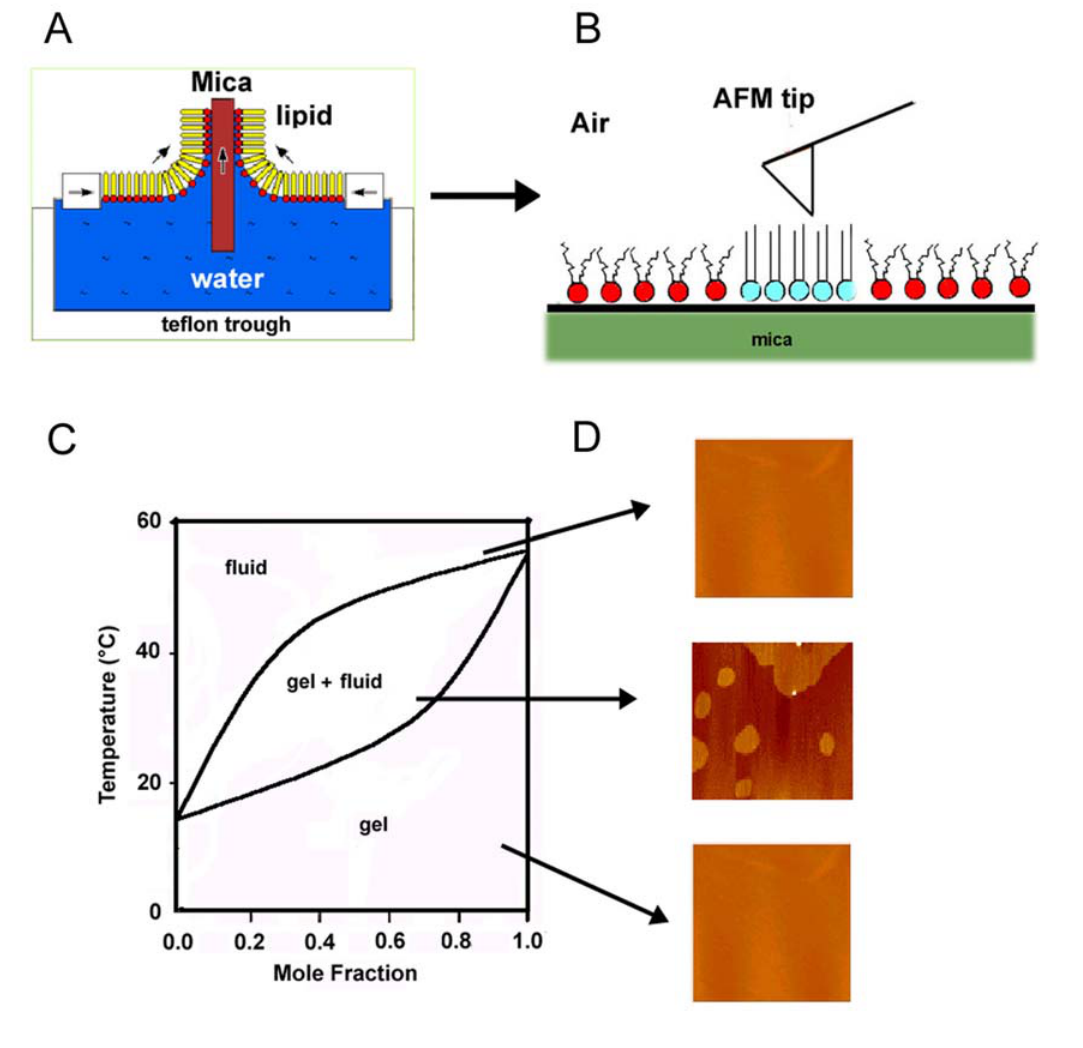
FIGURE 2 . Running AFM experiments on lipid film. (A) After spreading of lipids at the air/water interface of a Langmuir trough, the film is compressed up to the chosen surface pressure by two Teflon barriers and transferred onto a freshly cleaved mica piece; (B) the sample is placed under the AFM tip and examined in air, the methyl end of lipids in the ordered phase (LC, blue) protrudes from the fluid (red, LE) matrix; (C) hypothetical phase diagram showing the presence of an ordered/fluid coexistence region; (D) AFM representative images of one-phase films (top and bottom) and ordered-fluid phase separation region (middle). The protruding ordered phase domains appear as lighter zones surrounded by a darker fluid